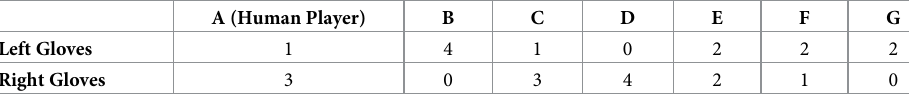
Table 3. Allocation of gloves to the seven players in the game with multiple core partitions.